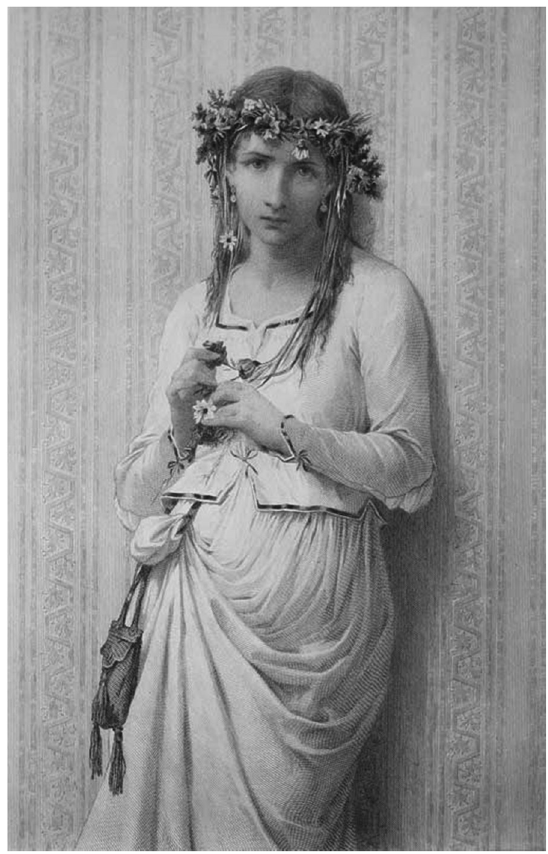
Figure 3: Jean Baptiste Bertrand, “ Ophelia, ” 1876, black and white etching - engraving. https://en.wikipedia.org/wiki/Jean -